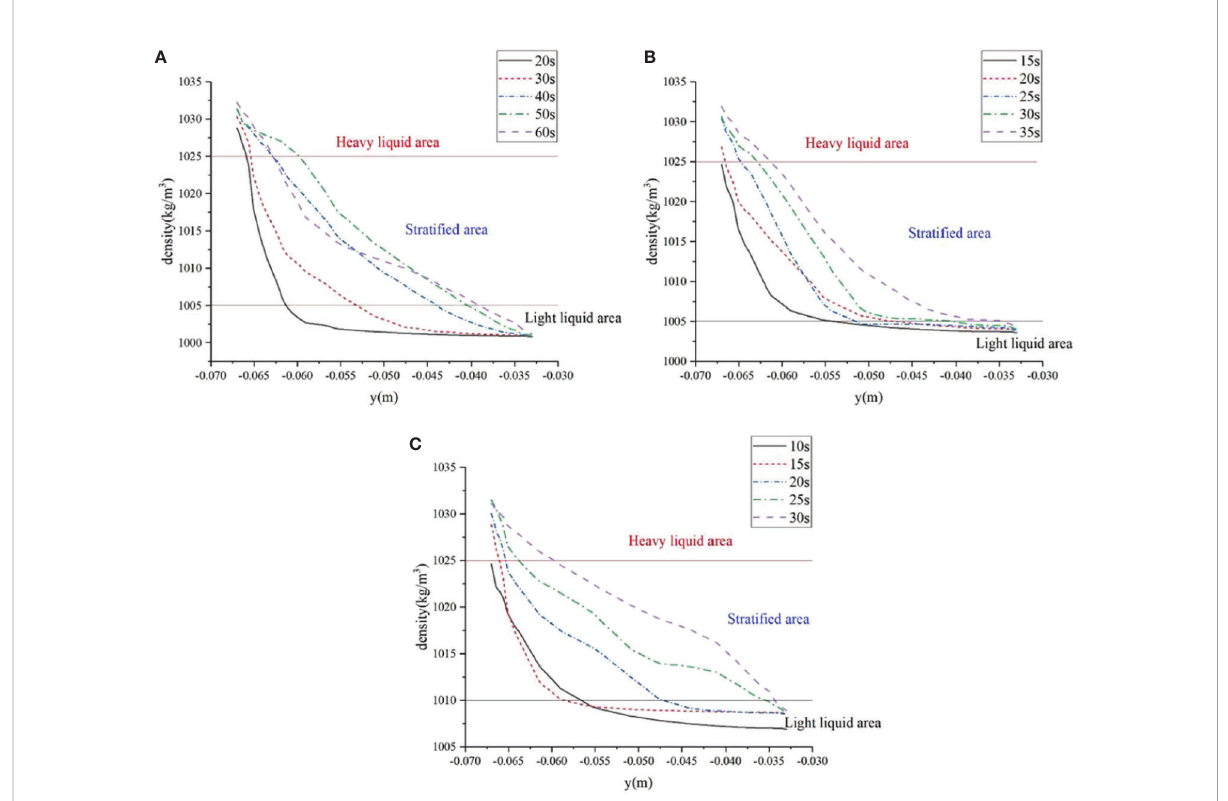
FIGURE 10 The density distribution curve of the central axis of the sampling cavity, (A) 0.044m/s, (B) 0.1m/s, (C)